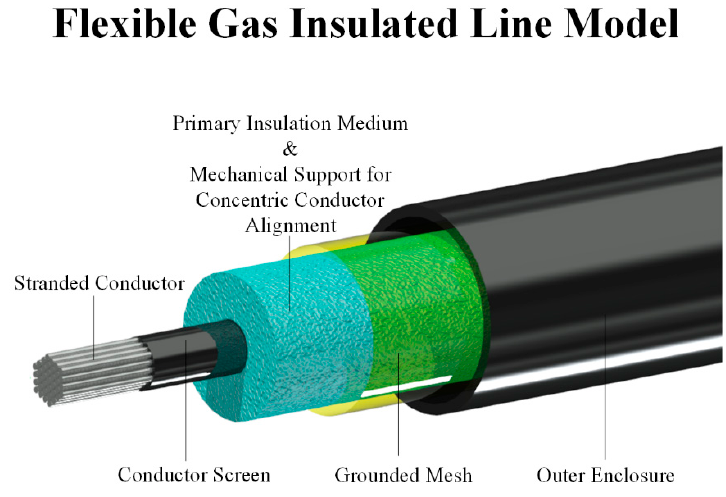
Figure 1. Schematic of flexible gas insulated line (FGIL).